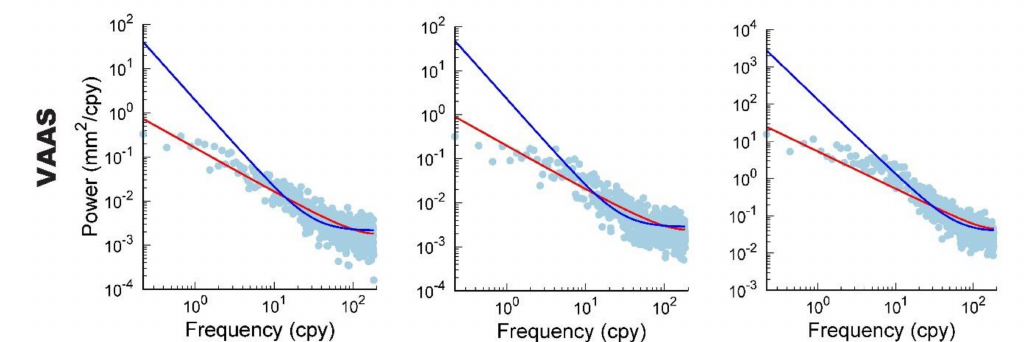
Figure 4. Power spectra density (PSD) for the East (E), North (N), and Up component for the three stations that experienced a dominant random walk noise model in the Up component.